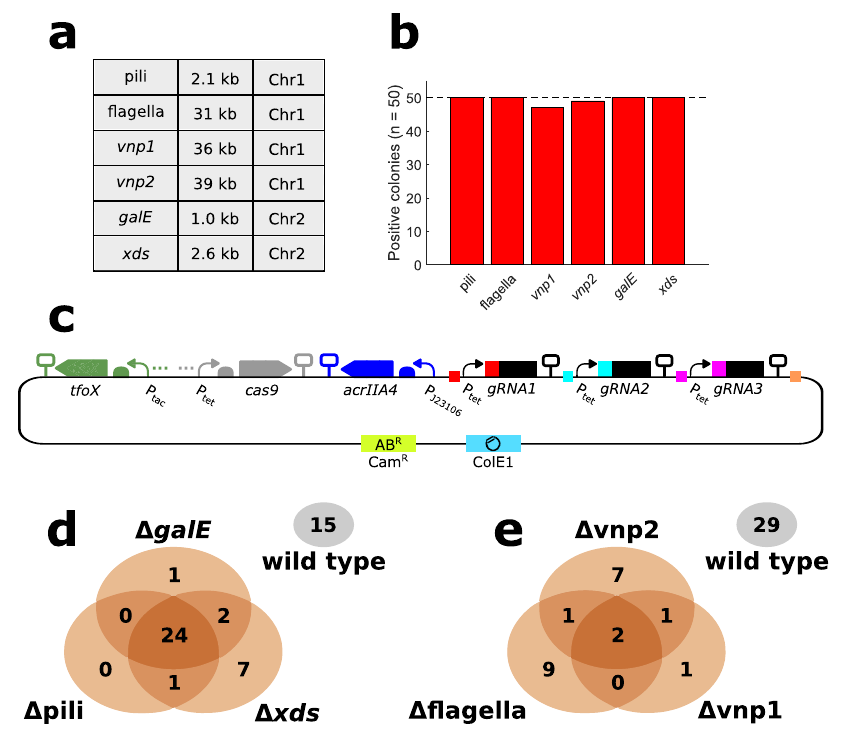
Fig. 3 Results of single and multiple deletions with NT-CRISPR. a Table providing information about deleted sequence. Locus tags of deleted genes are as follows: Pili (PN96_01310 - PN96_01315), fl agella (PN96_02540 - PN96_02685), vnp1 (PN96_04290 - PN96_04520), vnp2 (PN96_06880 - PN96_07085), galE (PN96_22140), xds (PN96_19285). Chr1 = Chromosome 1, Chr2 = Chromosome 2. b Ef fi ciency of deletions. Positive colonies were identi fi ed by PCR assays ( n = 50 colonies). The dashed line indicates the highest possible value. c Visualization of NT-CRISPR plasmid carrying three gRNAs. Colored squares indicate matching fusion sites used for construction of this plasmid using Golden Gate Assembly. More details regarding the assembly of a multi gRNA NT-CRISPR plasmid is provided in Supplementary Fig. S5a,b. SBOL symbols for omitted detail (three points) represent the transcriptional unit for the regulatory proteins LacI and TetR for P tac and P tet , respectively. d , e Venn diagrams to visualize results of multigene deletions. Note that areas of ellipses and intersections are not proportional to the displayed values. Colonies of cells carrying none of the deletions are indicated with a separate ellipsis (gray). Results were obtained by PCR assays ( n = 50 colonies). Plasmids used are pST_138 ( d ) and pST_137 ( e